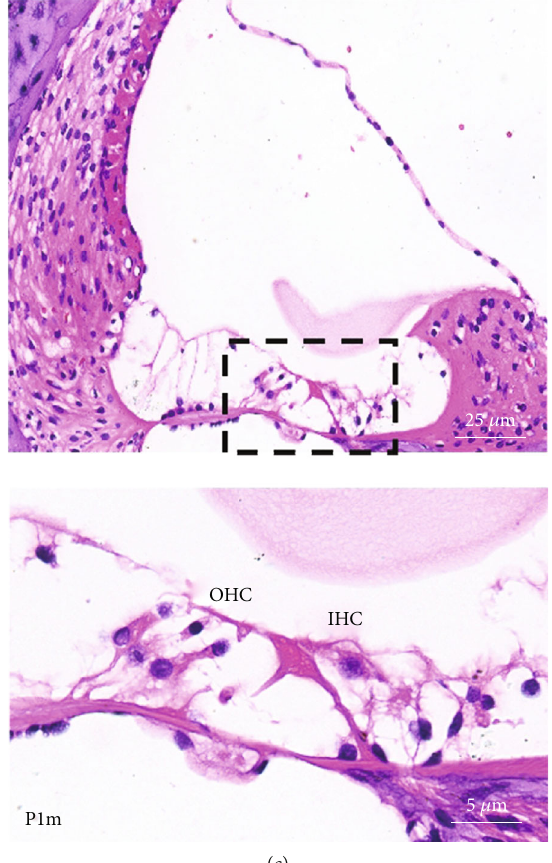
Figure 3: Hearing and basilar membrane morphology of Clu -/- mice in one month. (a) ABR hearing thresholds and DPOAE hearing threshold were measured at 32, 16, and 8 kHz in Clu − / − and WT mice at P1m. N = 6 . (b) Cochlear basilar membrane morphology of Clu − / − mice at P1m. (c) Organ of Corti in the basal cochlear regions of P1m Clu − / − mice. No hair cells or supporting cell defects were